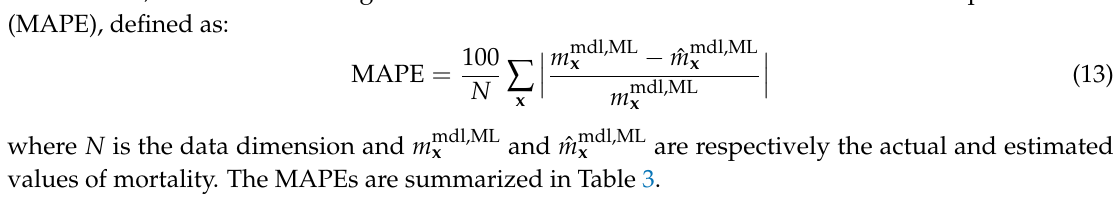
Table 3. MAPE of fitted with respect to observed data for the LC, RH, and Plat model, before (No ML) and after (DT, RF, GB) the application of ML algorithms. Ages 0–100 and years 1915–2014, Italian population. Values in bold indicate the specification with the smaller MAPE for each model. Gender